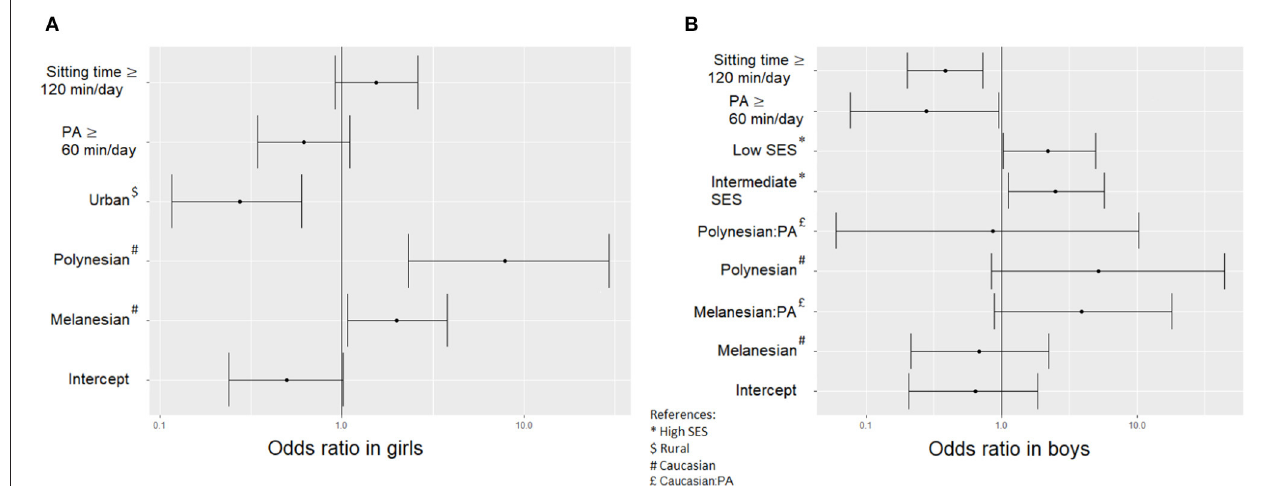
FIGURE 7 | Odds ratio and error bars for the multivariate logistic regressions estimating the chance of being overweight or obese in (A) female adolescents and (B) male adolescents.